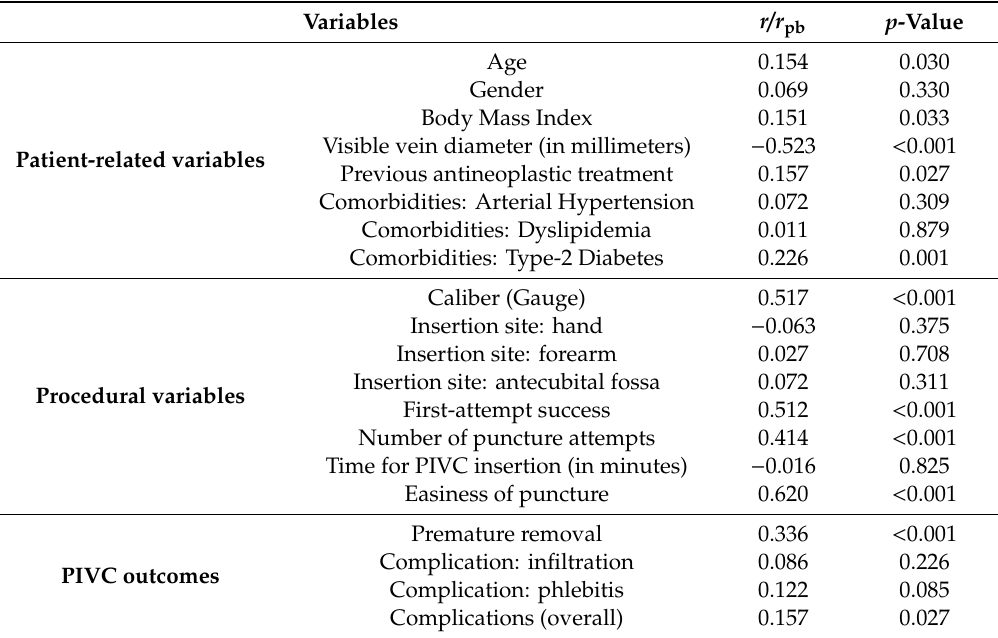
Table 4. Correlation matrix for the A-DM scale ( n =